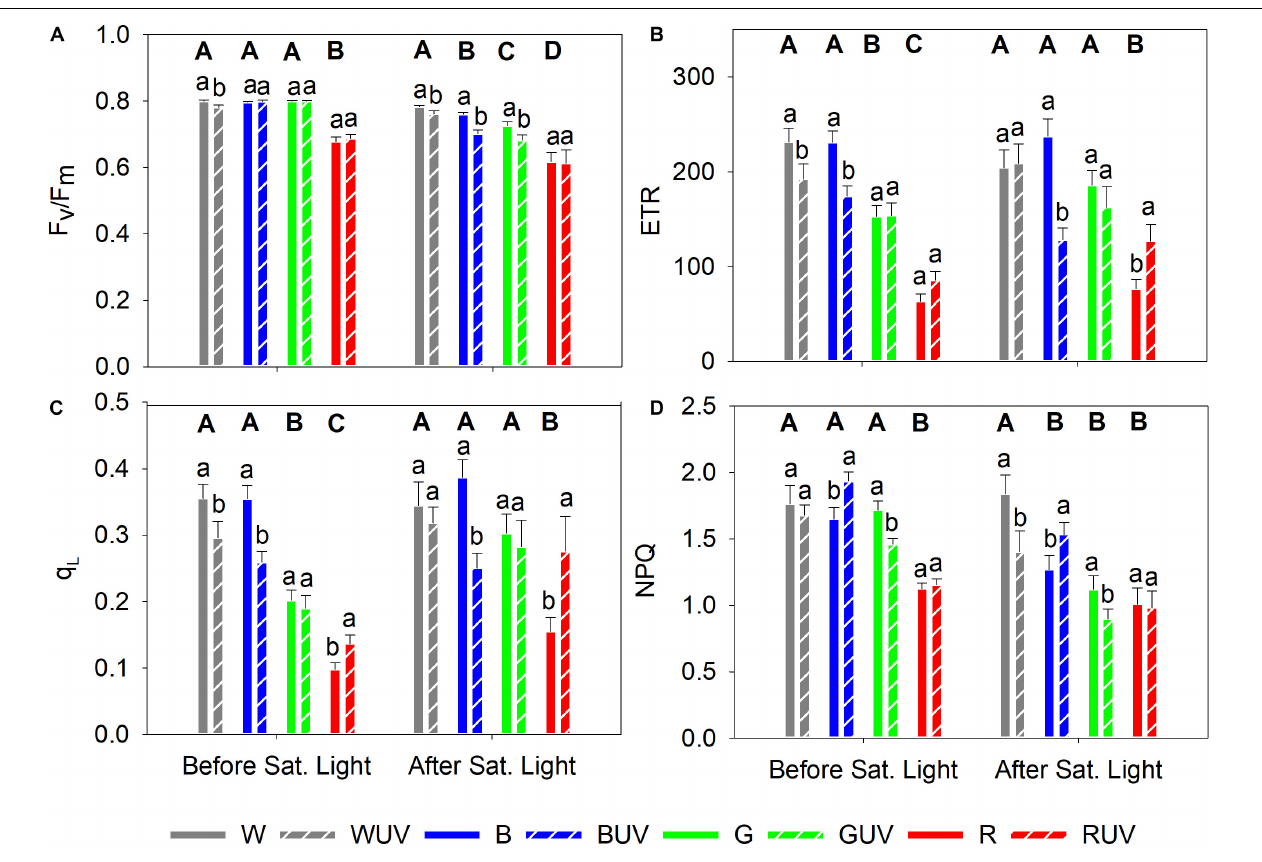
FIGURE 4 | Chlorophyll fluorescence parameters measured in cucumber plants grown under four different PAR qualities (White, Blue, Green, and Red) and without (solid bars) or with (dashed bars) exposure to supplementary UV-B radiation for 14 days, prior to and after a 5 h saturating light treatment (1600 µ mol m − 2 s − 1 ). (A) Maximum photochemical efficiency (F v /F m ); (B) Apparent electron transport rate (ETR); (C) Fraction of oxidized PSII (q L ), (D) Non-photochemical quenching (NPQ). Bars represent mean values (Before saturating light: n = 21 ± SE; After saturating light n = 15 ± SE). Capital letters indicate significant differences between growth light qualities without UV-B and lower-case letters between non-UV-B-exposed plants and UV-B exposed plants within the same PAR background, both at P < 0.05.